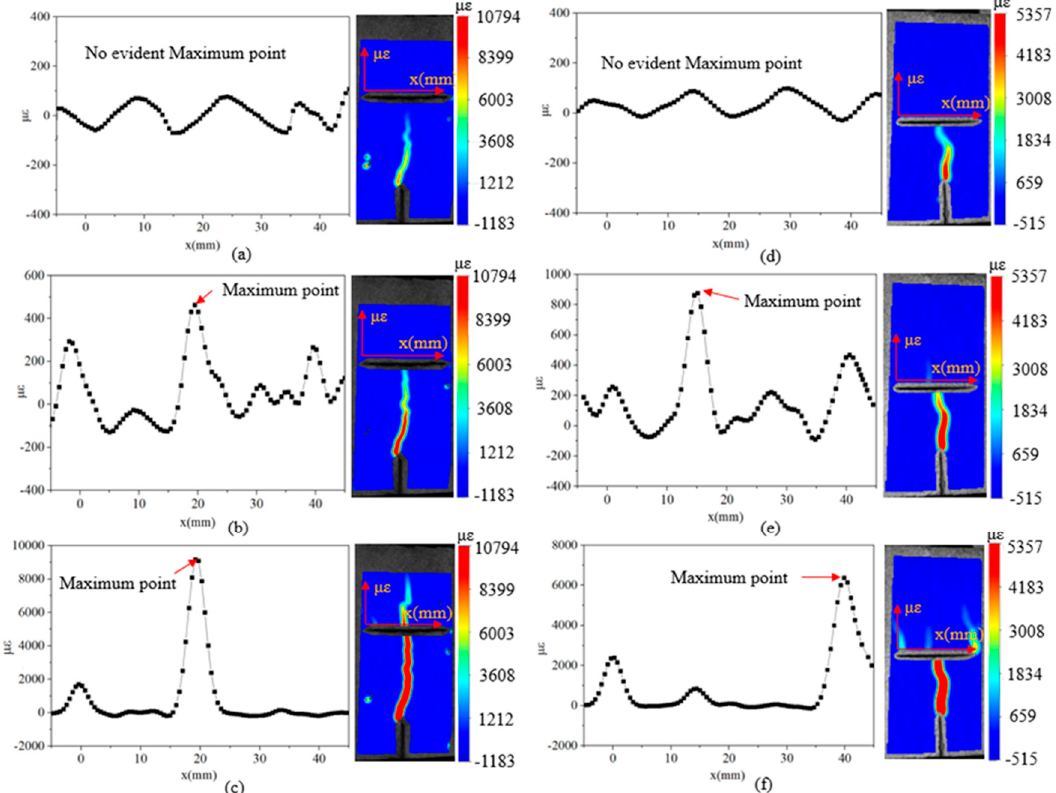
Figure 18. The distribution of strain on the upper surface of preset crack. ( a ) The distribution of strain before the propagating crack reaches the preset crack (the restart point at the middle point of the preset crack); ( b ) The distribution of strain when two cracks interact (the restart point at the middle point of the preset crack); ( c ) The distribution of strain after two cracks interact (the restart point at the middle point of the preset crack); ( d ) The distribution of strain before the propagating crack reaches the preset crack (the restart point at the tip of the preset crack); ( e ) The distribution of strain when two cracks interact (the restart point at the tip of the preset crack); ( f ) The distribution of strain after two cracks interact (the restart point at the tip of the preset crack).